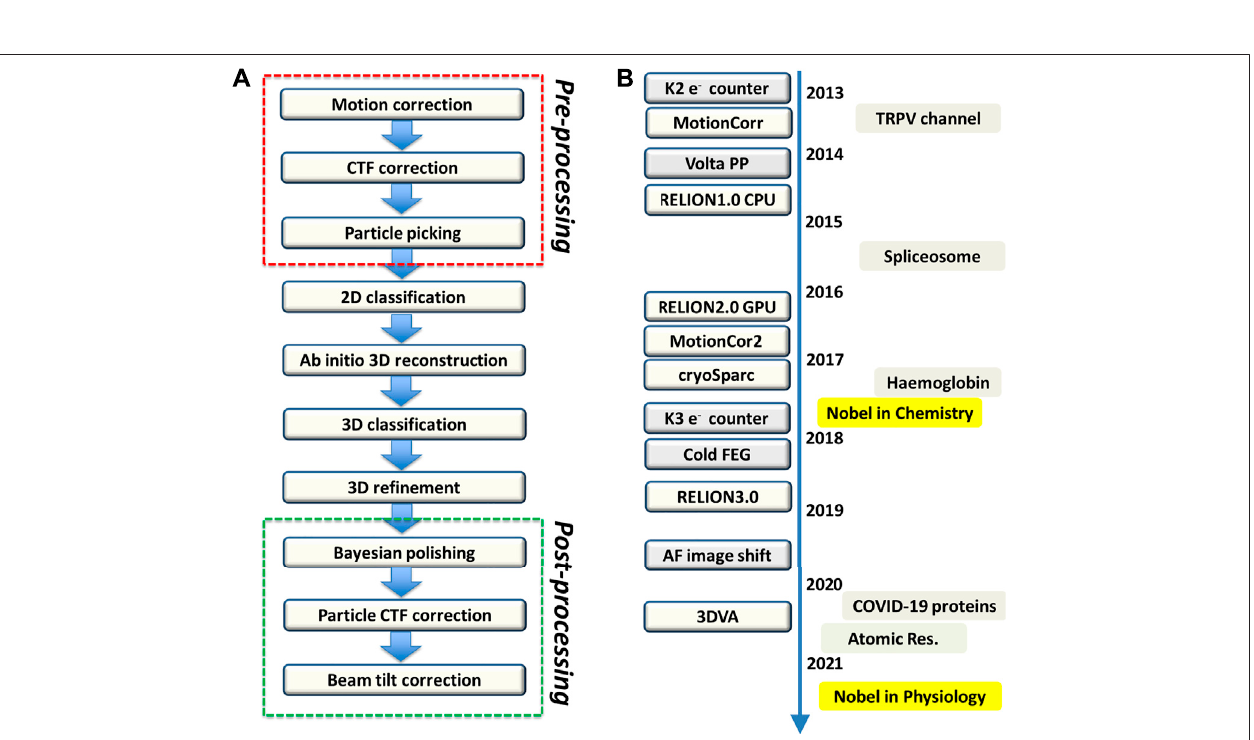
FIGURE 2 | Single particle cryo-EM processing and milestones (A) Single particle processing. There are in general a total of 10 steps in the processing where the red box encloses the pre-processing steps, which can be executed in an on-the- fl y manner. At the bottom, the post-processing steps encased by the green box are usedtoimprovetheoverallresolutionandlocalmapqualityaswell.BayesianpolishingonRELIONtakescareofthedoseweightingtocompensatetheframe-dependent radiation damage effect. Once ahigh-qualitymap is obtained, thevariation ofdefocus and higher order aberration at per particle level canbe further estimated and corrected. (B) Cryo-EM milestones. The boxes on the left of the timeline highlight key advancement of hardware and software where “ AF image shift ” stands for “ aberration-free image shift. ” The boxes on the right of the timeline indicate signi fi cant cryo-EM structures and events including recent rapid structure determination of COVID-19proteins,achievement ofatomicresolutionwithapo-ferritin,and theNobel Physiology orMedicinein2021thatrecognizes thediscoveriesofTRPVand Piezo channels as heat and pressure sensors respectively where the structures were solely obtained by